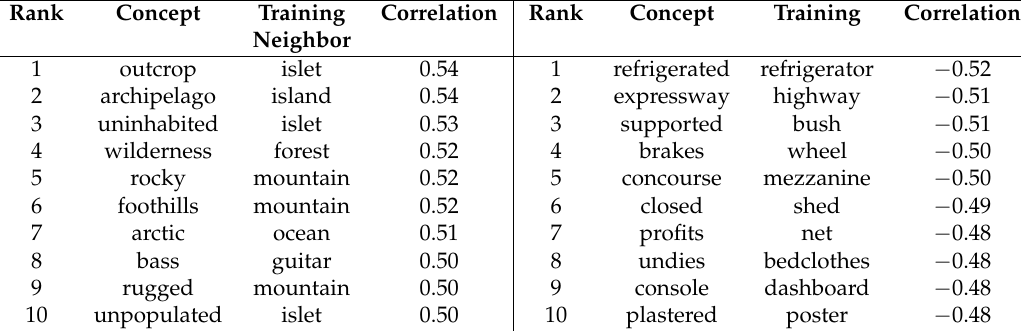
Table 2. Top 10 new concepts from GloVe positively (left) and negatively (right) correlated with scenicness in the latent